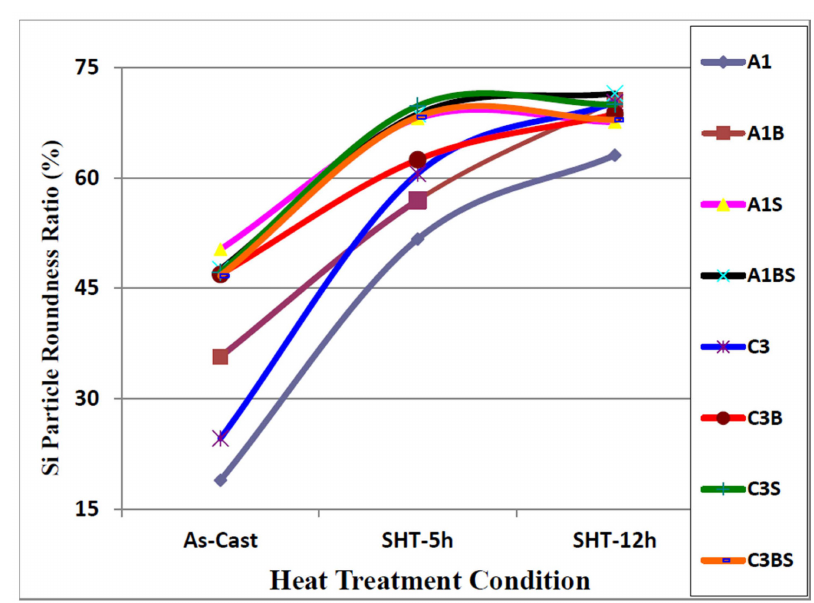
Figure 6. Variation in particle roundness of eutectic silicon as a function of heat treatment condition, DAS ~ 25 µ m.